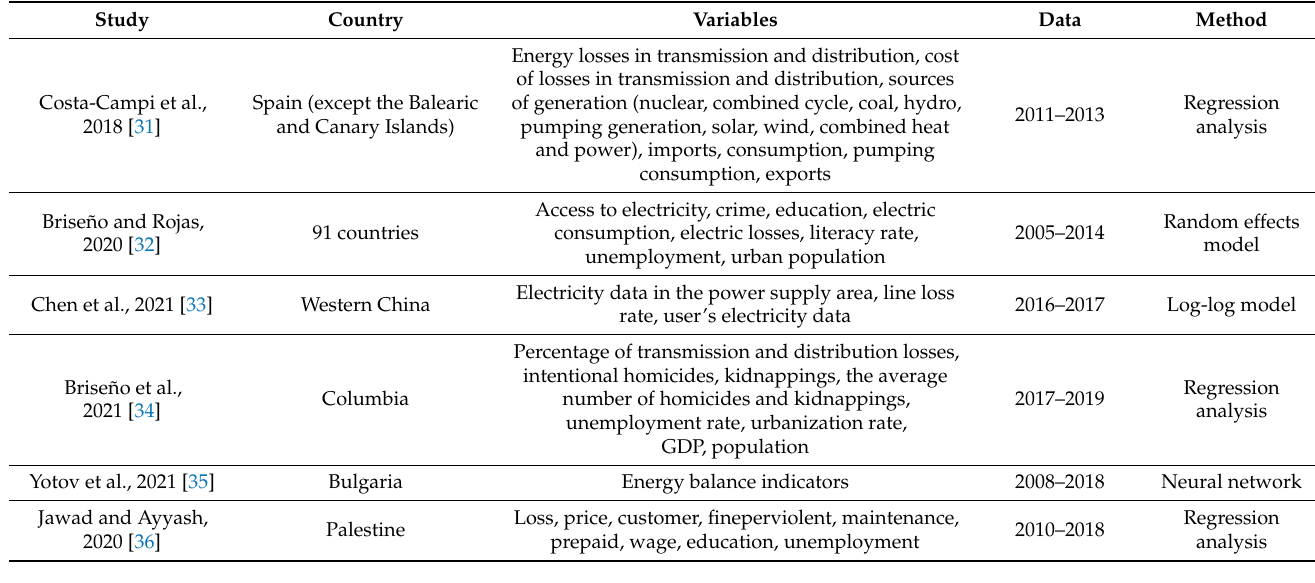
Table 3. Summary of the resent studies on the electricity losses.